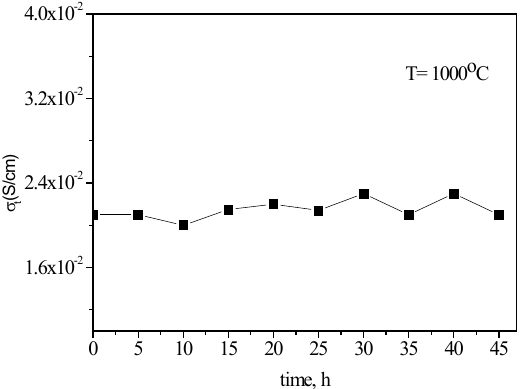
Figure 10. The changes of energy activation for bulk and grain- boundary conductivity for investigated CaZrO